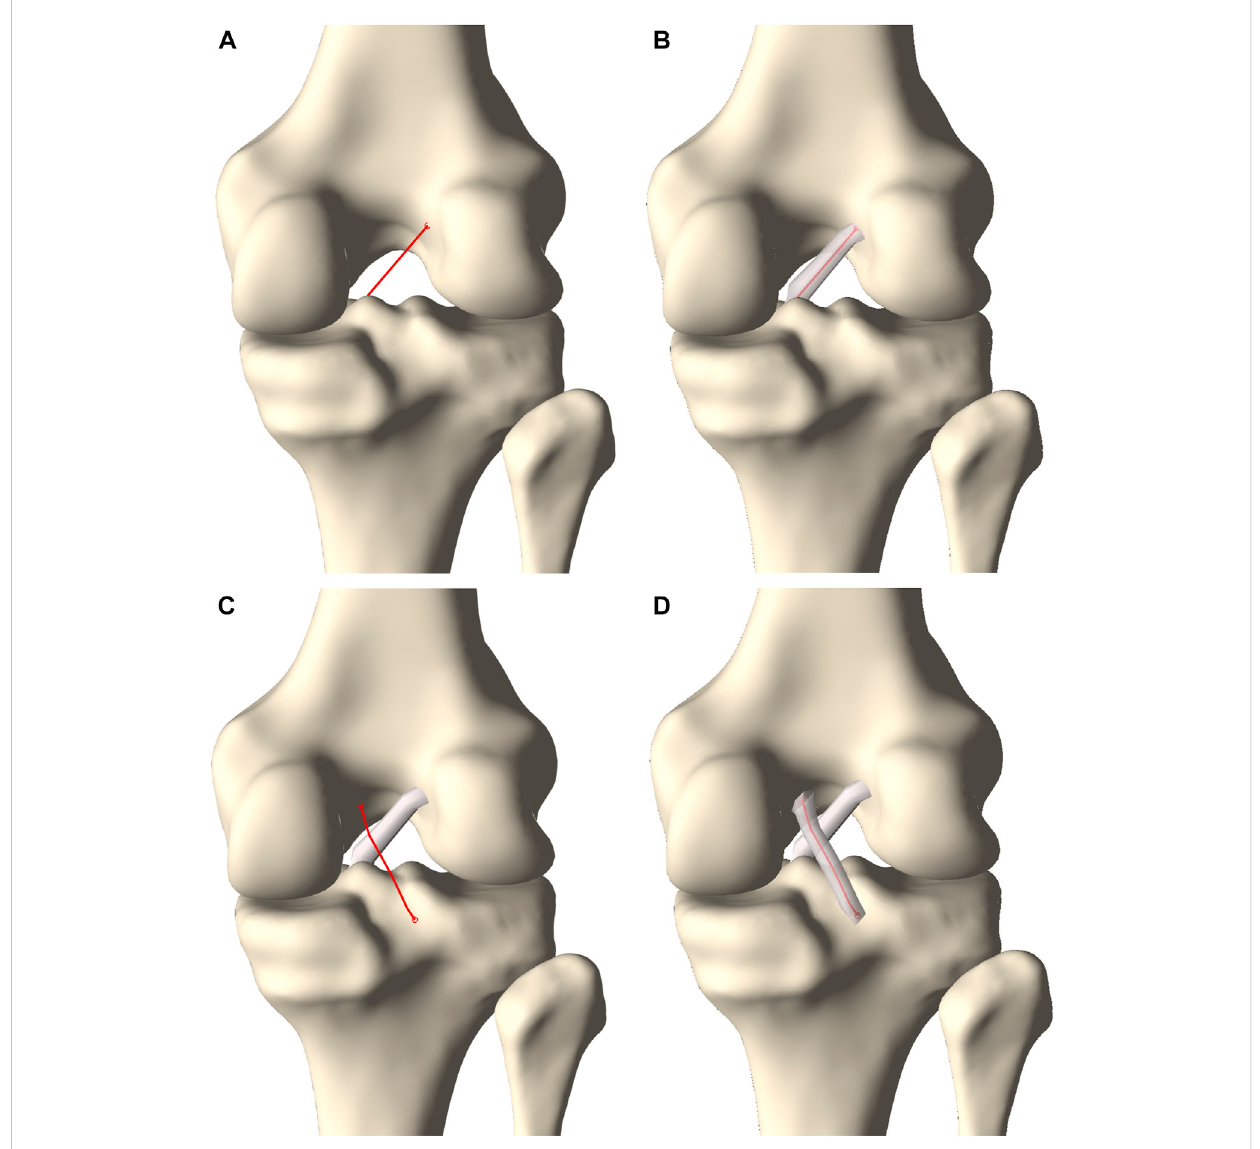
FIGURE 6 Posterior view on the knee. (A) A centerline was generated connecting the femoral ACL origin and the tibial ACL insertion. (B) A tube with varying radius was fi tted around the centerline to model the ACL. (C) A second centerline was forced to wrap around the ACL when connecting the femoral PCL origin and the tibial PCL insertion. (D) A tube fi tted around the centerline with a varying radius formed the